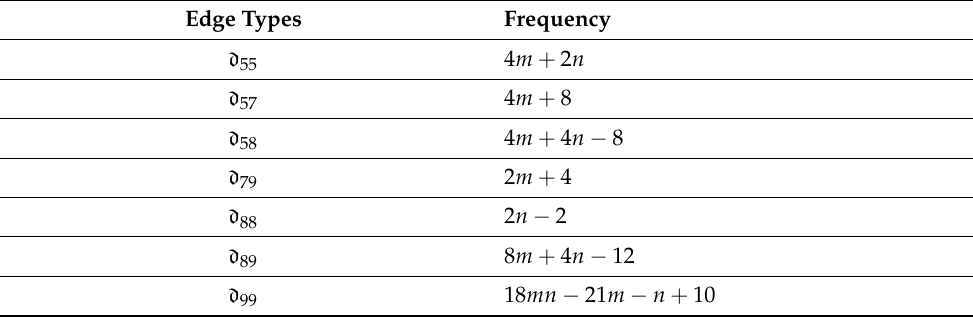
Table 2. Partition table for β